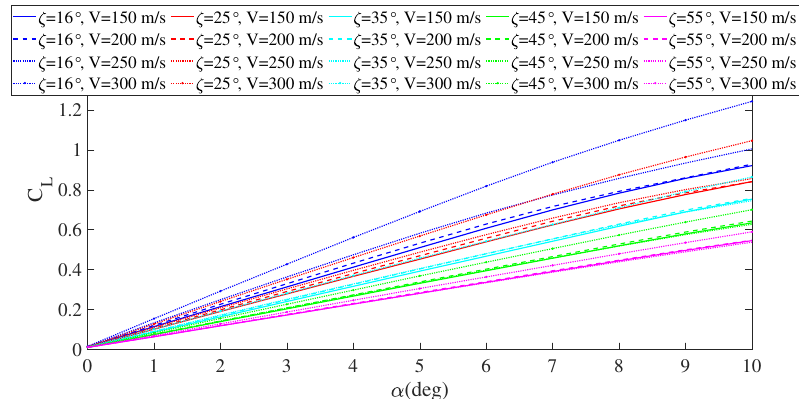
Figure 4. The lift coefficients C L for different conditions of V and ζ under h = 7000